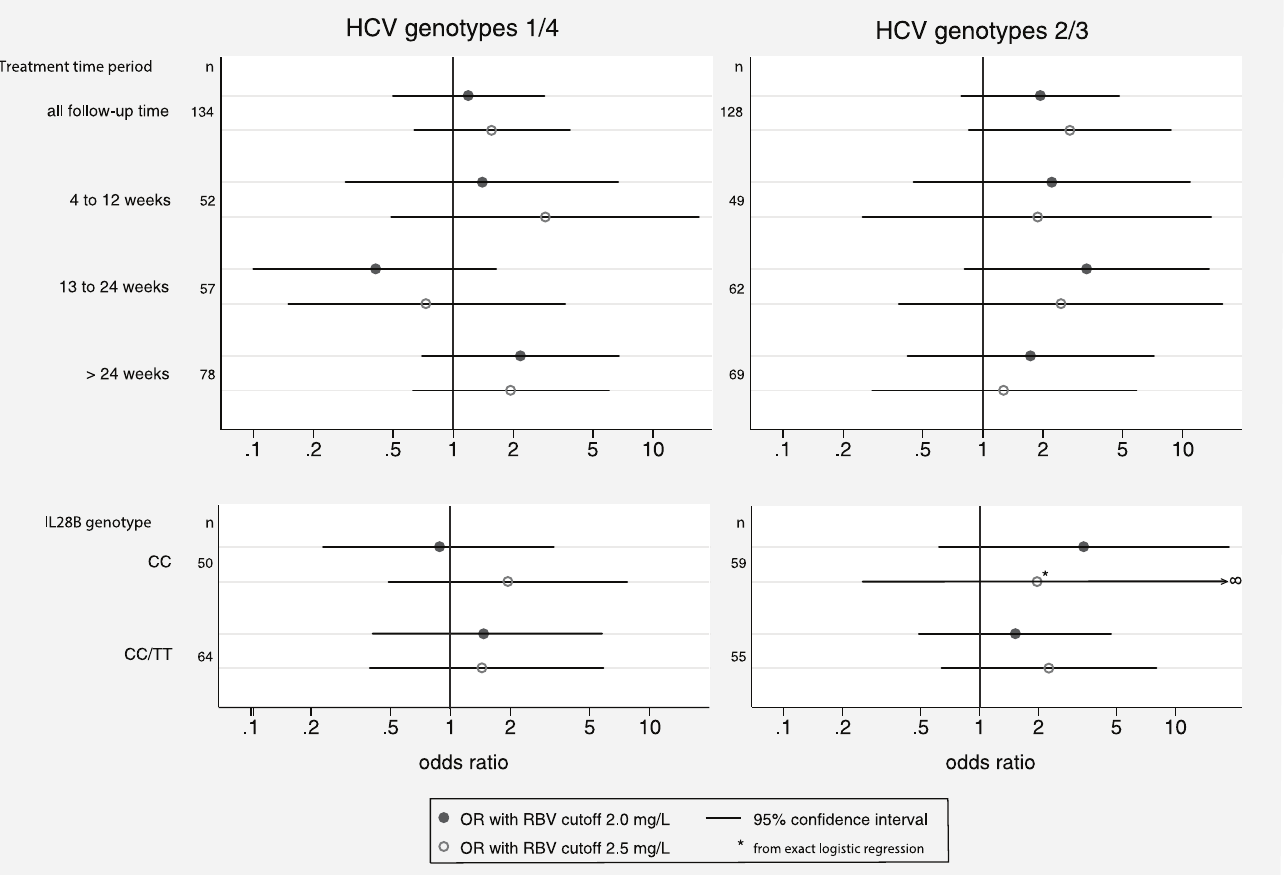
Fig 3. Impact of ribavirin level (cid:1) 2.0 mg/L and (cid:1) 2.5 mg/L on sustained virological response (SVR), stratified by HCV genotype group, treatment phase and IL28B genotype. Multivariable logistic regression analysis, adjusted for age, sex, HIV transmission group and HCV RNA level. Abbreviations: CI, confidence interval; HCV, hepatitis C virus; OR, odds ratio; RBV, ribavirin.